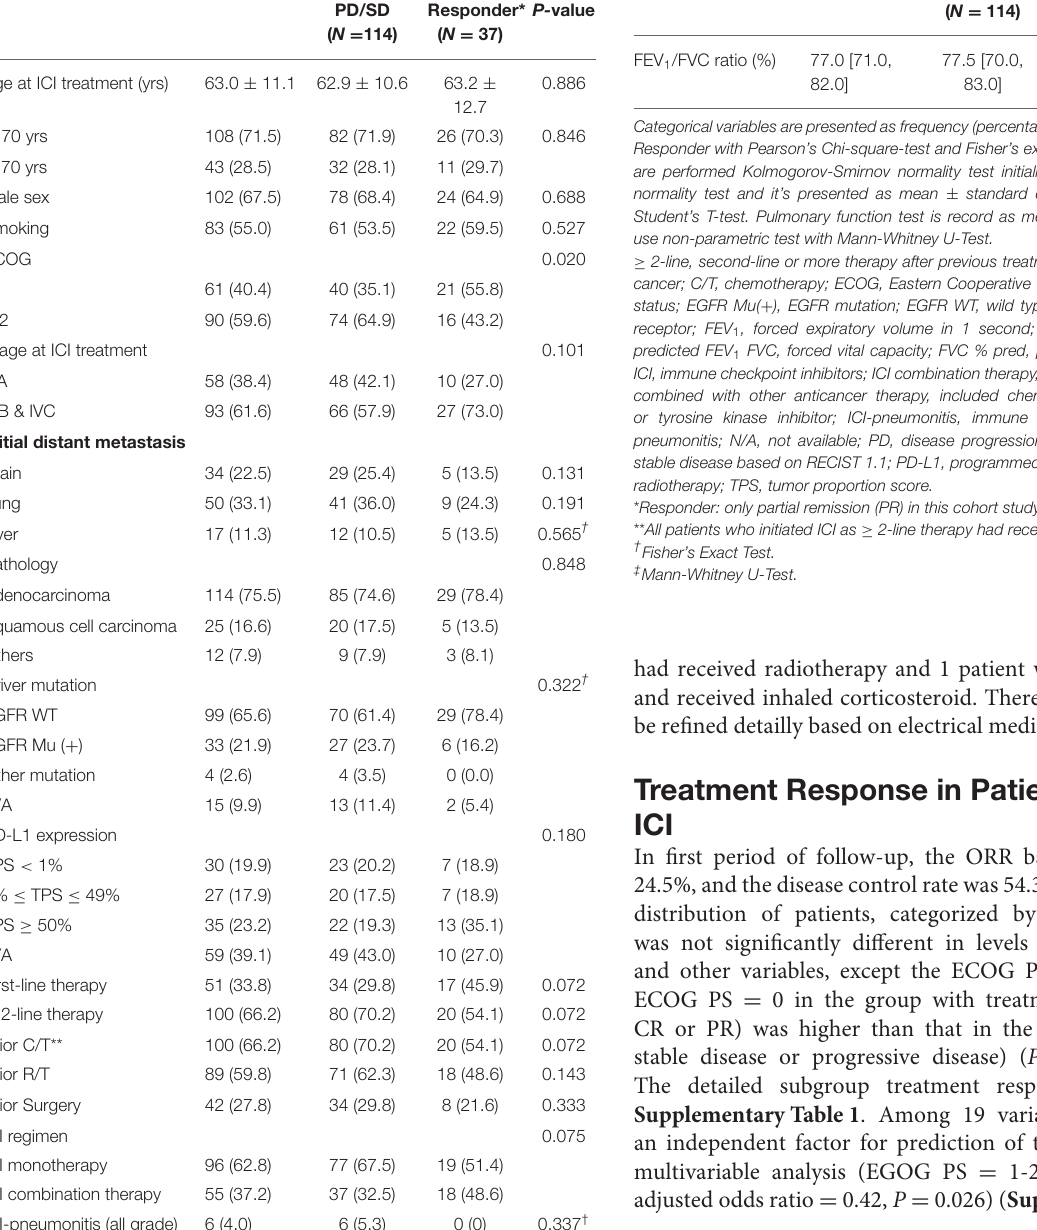
TABLE 1 | Demographics and characteristics of patients undergoing immune checkpoint inhibitors treatment and characteristics based on treatment response.